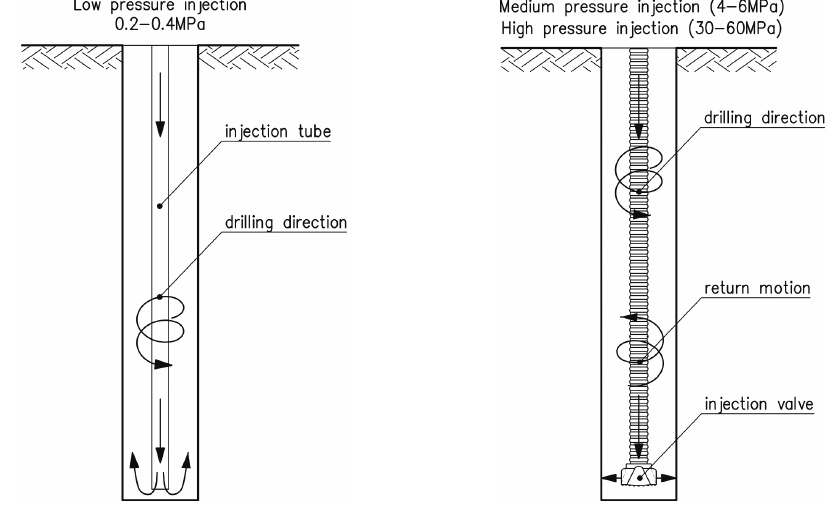
Fig. 1a. Diagram of low pressure injection Fig. 1b. Diagram of medium and high pressure